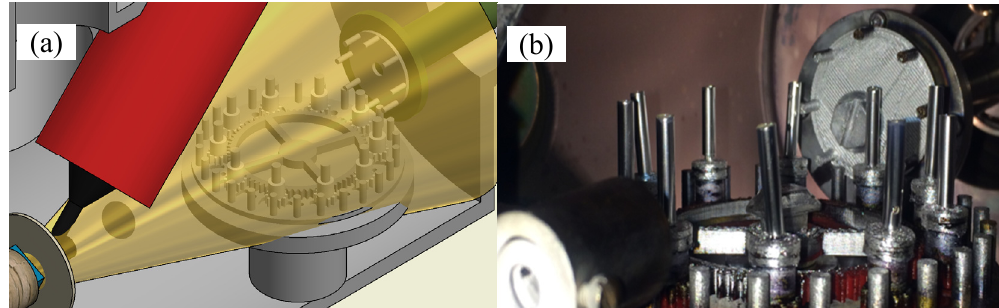
Figure 2. Mobilization system for the deposition by PEA onto CVCs. ( a ) CAD axonometric view of the deposition camera, with the plasma plume (yellow) that propagates from the target surface toward the CVCs; these latter are placed in vertical position at regularly spaced holders on the internal rotating gear, thus to cover only their external surface ( b ).